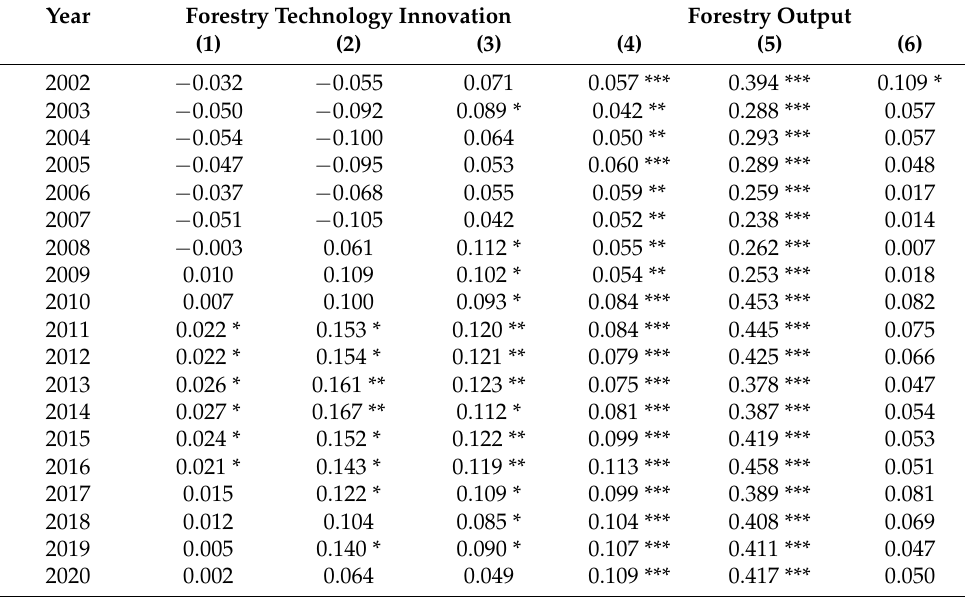
Table 3. Global Moran Index based on FTI and forestry